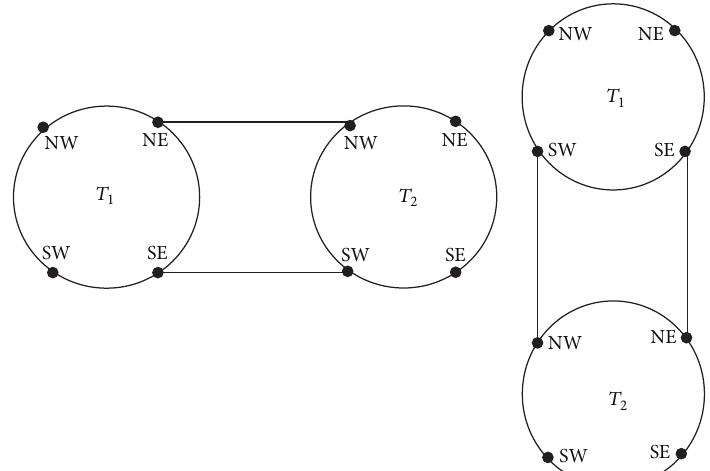
Figure 6: Addition and multiplication of